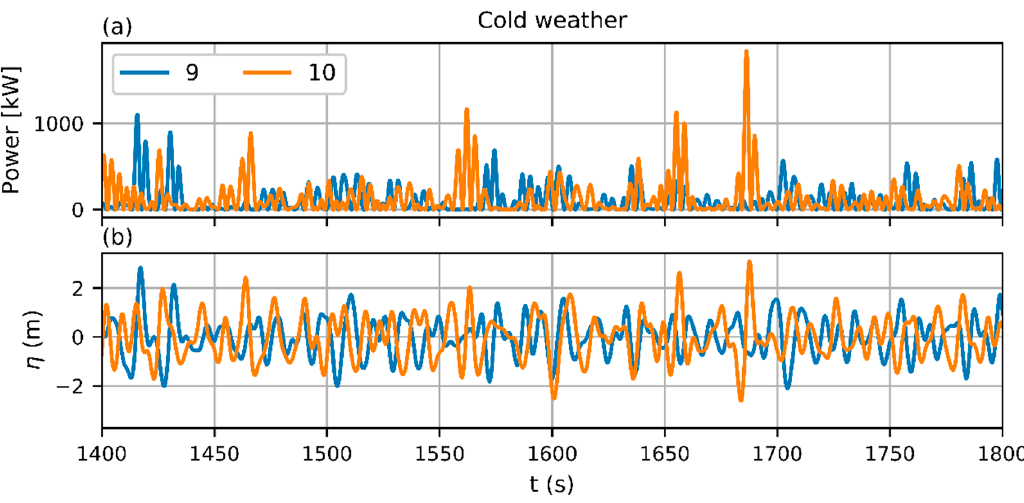
Figure 14. ( a ) Power production and ( b ) water surface elevation at WEC stations 9 and 10 for the third realization (k3) of the cold weather case.